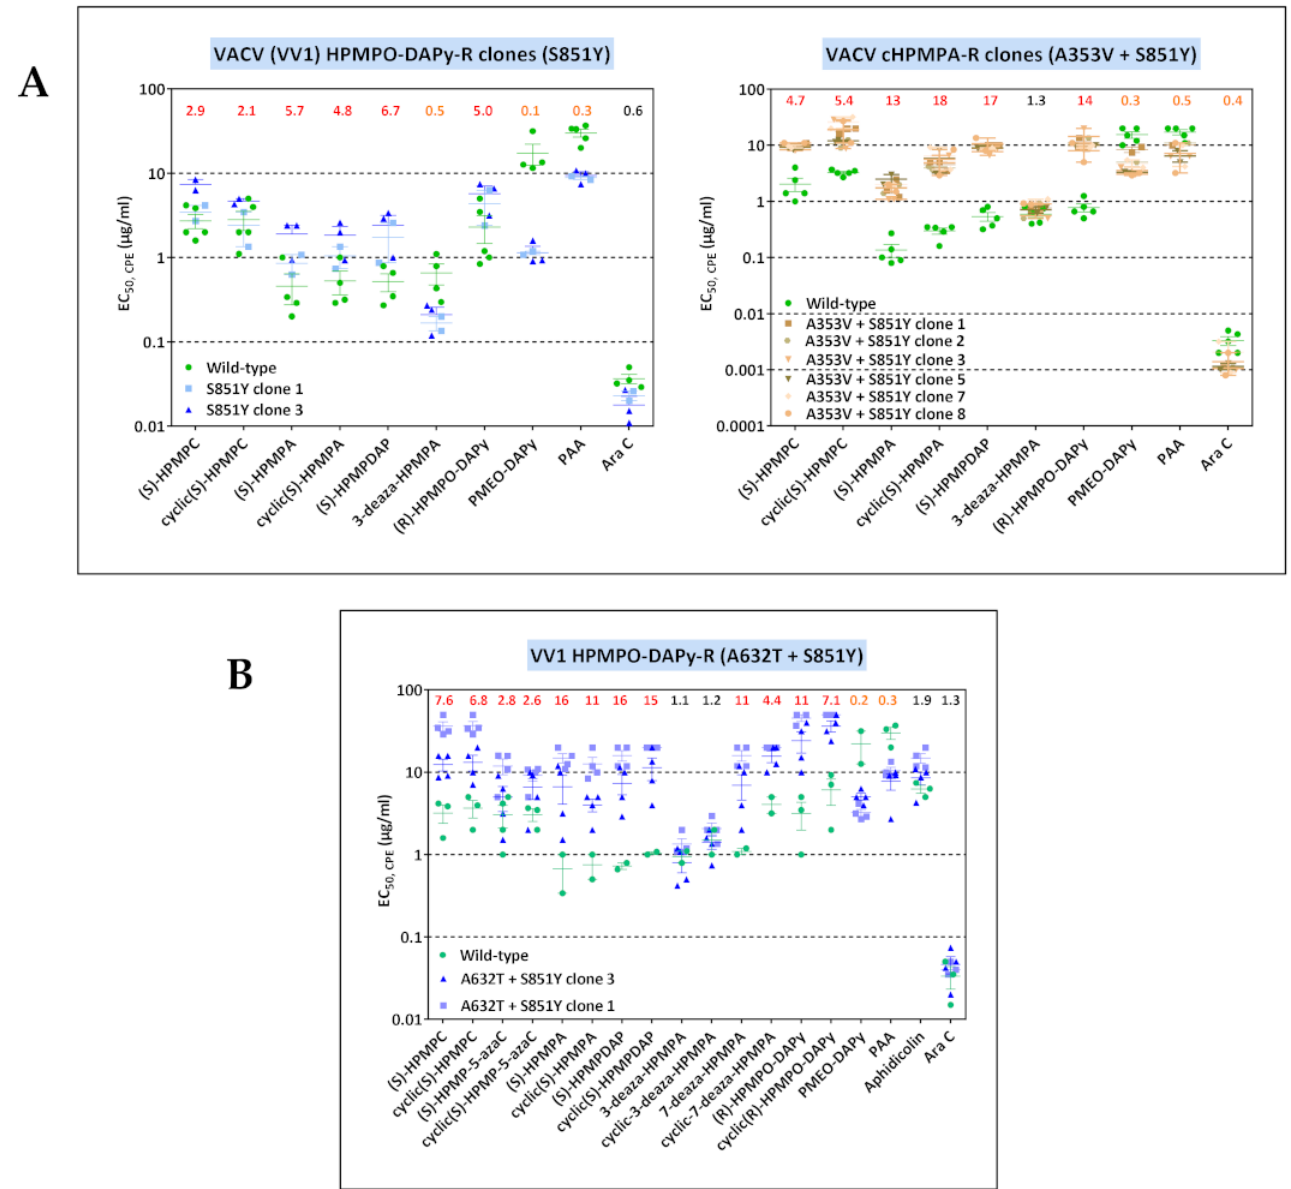
Figure 1. ( A ) Drug-susceptibility profile of cHPMPA-R VACV clones (A353V + S851Y) compared to VACV clones bearing the single S851Y DNA pol change recovered from VV1 HPMPO-DAPy-R #15. Drug-resistance properties of different plaque-purified viral clones bearing the single amino acid (S851Y) or double amino acid (A353V + S851Y) substitutions as determined using a CPE reduction assay with HEL fibroblasts. ( B ) Drug-susceptibility profile of selected VV1 HPMPO-DAP- R viral clones to evaluate the impact of the A632T + S851Y DNA polymerase substitutions. The A632T + A684V clones were recovered from VV1 HPMPO-DAPy-R #32. Drug-resistance properties of the different types of viral clones were established using a CPE reduction assay with HEL fibroblasts. The effects of different drugs on viruses encoding the indicated mutations were determined by calculating the EC 50 values for the parental wild-type strain and clones bearing the specific mutations. At least two independent experiments were performed for each test compound. Horizontal lines for each drug and mutant viral clones indicate the mean values ± standard deviation. The fold resistance (ratio of the EC 50 for the mutant viruses to the EC 50 for the corresponding wild-type virus is marked at the top of the graph. VACV viral clones showing a ≥ 2-fold increase (red, bold) were considered drug resistant (R) and those with a ≤ 0.5-fold decrease (orange, bold) drug hypersensitive